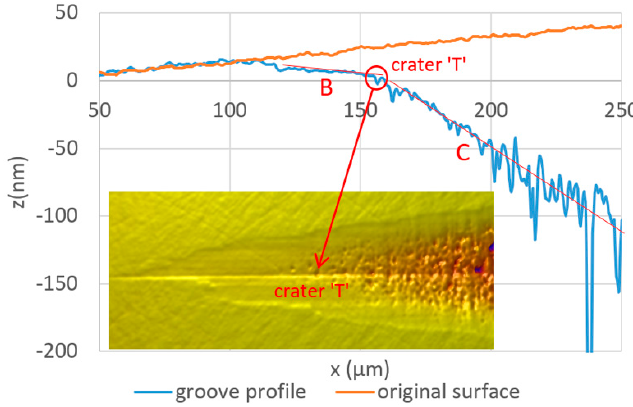
Figure 9. Groove profile along the centre line.